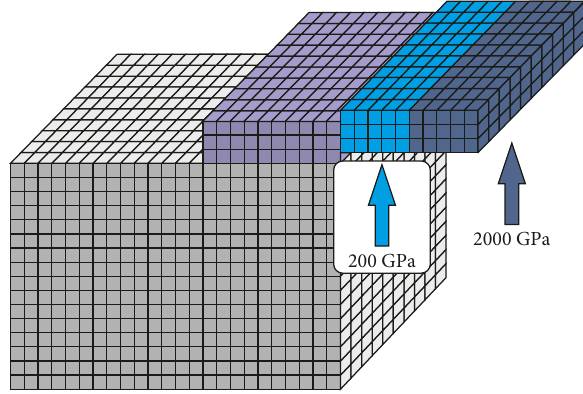
Figure 10: The impactor model consisting of two parts of varying